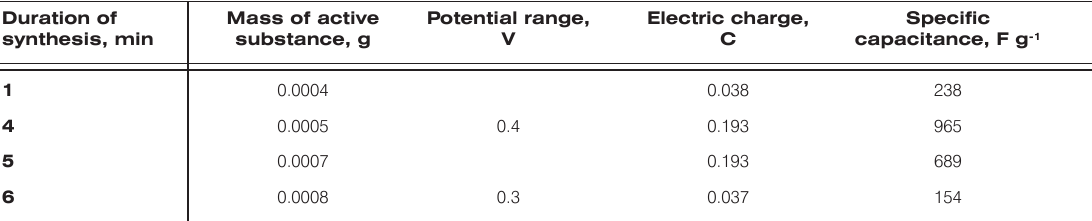
films on Bekipor ST 20AL3 mesh. 2